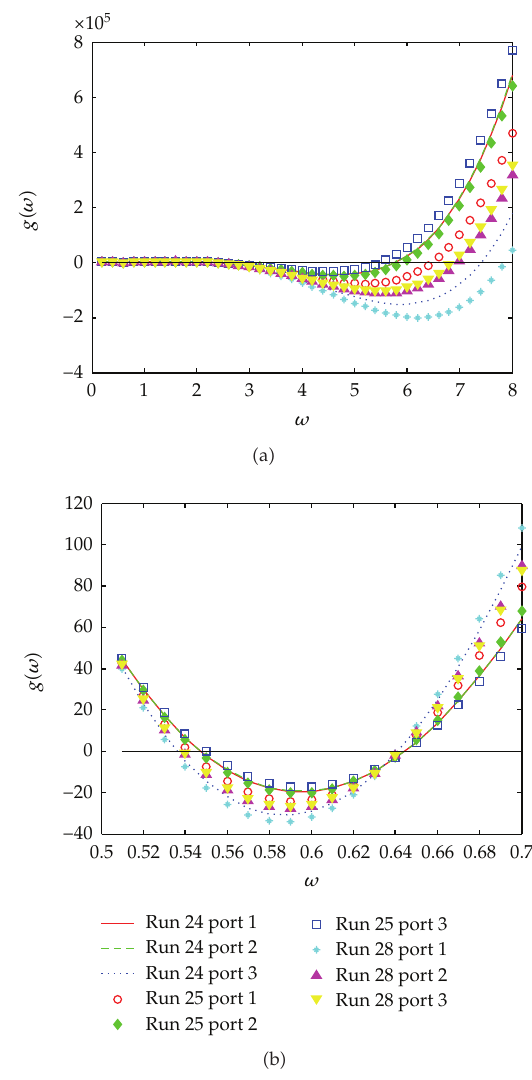
Figure 8: g (cid:2) w (cid:3) for Runs 24, 25, and 28 over (cid:2) a (cid:3) a wide range of ω from 0 to 8 and (cid:2) b (cid:3) a narrow range of ω